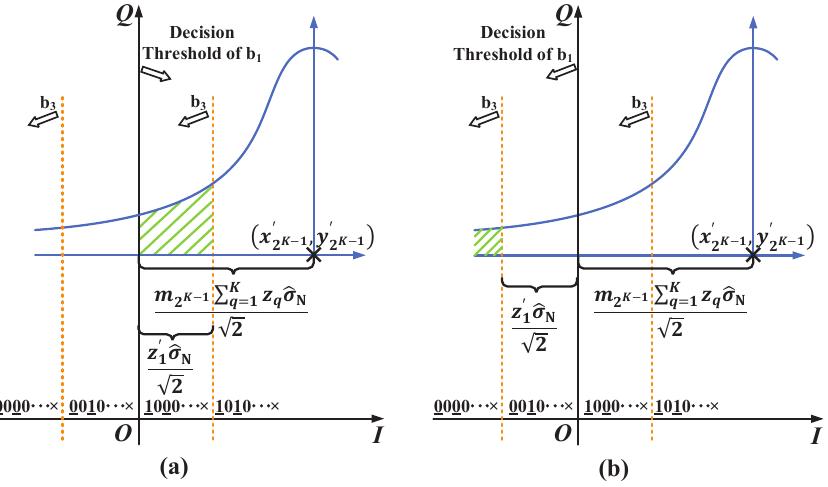
) for deriving BER , y (cid:48) 2 K − 1 2 K − 1